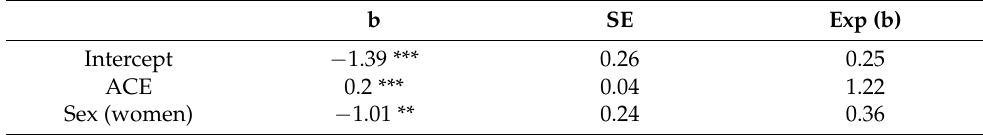
Table 9. Poisson model for criminal behaviors.